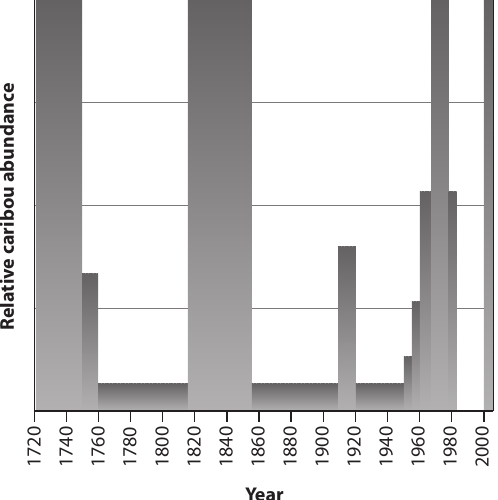
Fig. 8. Historical rise and fall cycles of relative caribou abundance in West Greenland based on Vibe (1967), Meldgaard (1986) and the 2001 abun- dance estimate. Only general trends are illus- trated, since the caribou populations in West Greenland do not cycle in absolute synchrony (Meldgaard, 1986), and estimates were unavail- able except for in 2001. During periods of low abundance, records suggest the caribou had disappeared almost entirely. No harvest records were available from 1983 to